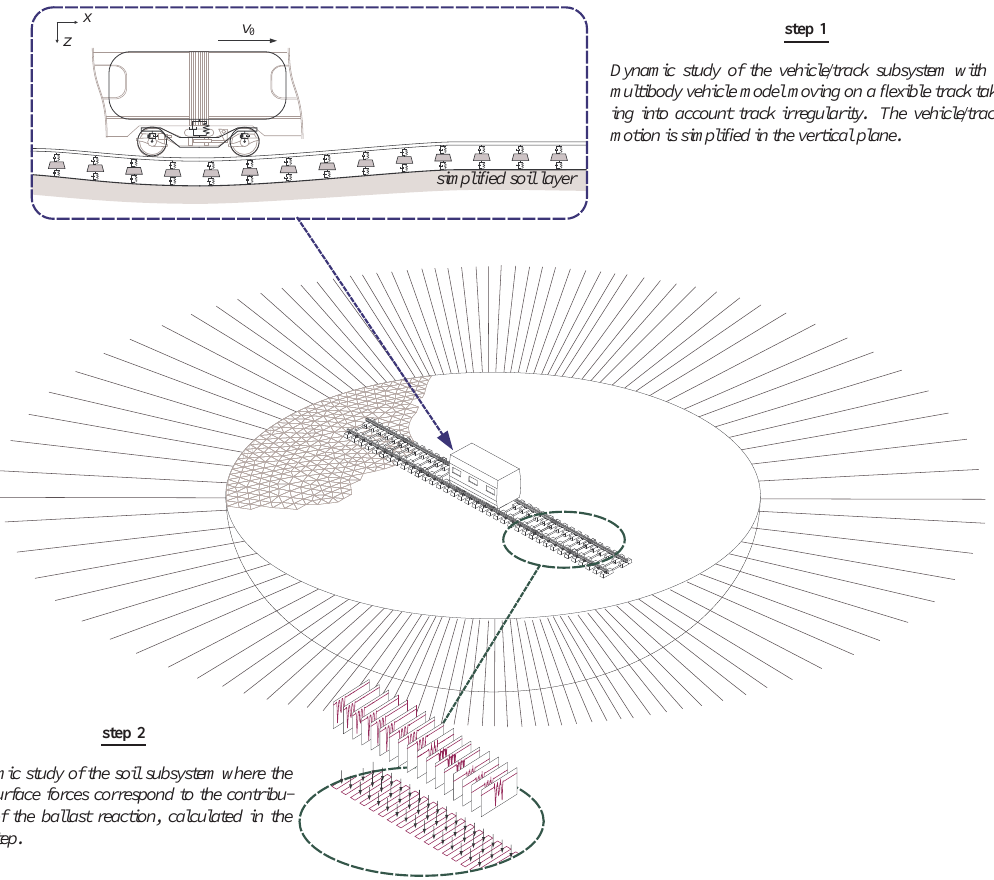
Figure 1. Vehicle / track / soil model, working in two successive steps known as Winkler foundation, this term being used for con- tinuously supported track and for discrete model as well as), the hypothesis is valid if the soil is su ffi ciently sti ff , which is the case in most of railway lines (Kouroussis et al., 2011e, 2012a). With softer soils, the authors have proposed an en- hanced track model, referred to as the coupled lumped mass model (CLM), which o ff ers a faithful representation of soft soils impedance in the requested frequency range (Kourous- sis et al., 2011b). In this paper, we will focus on the vehi- cle / track model.